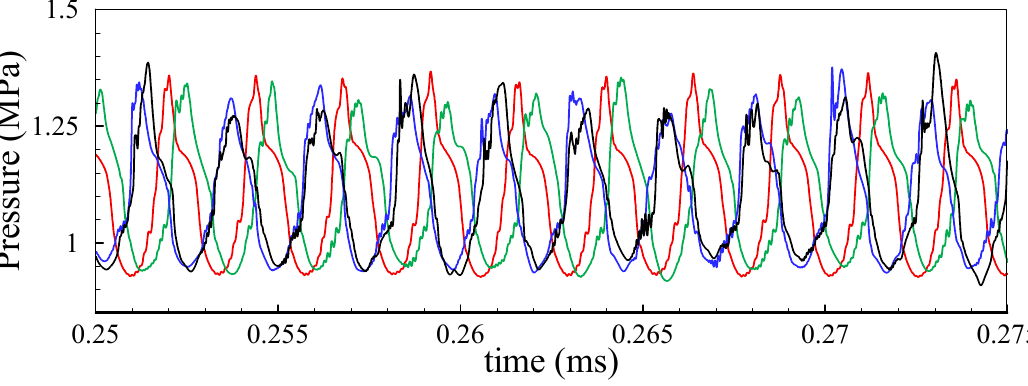
Figure 10. Pressure probed along the stagnation point for various grid resolutions (red—150 × 200; green—200 × 300; blue—300 × 450; and black—400 × 600).